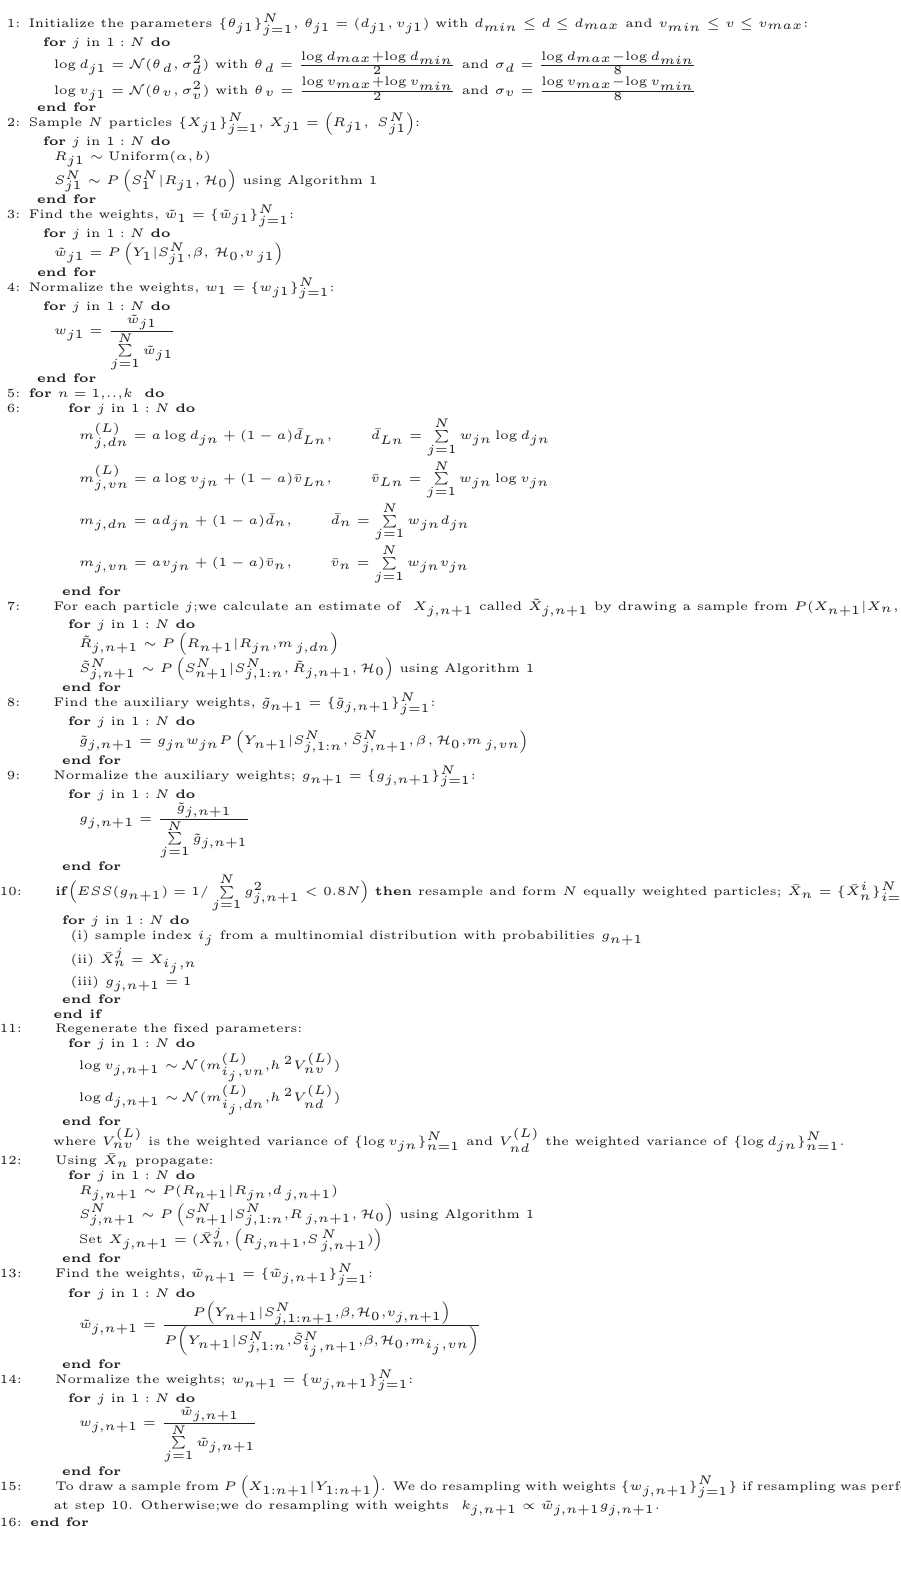
Algorithm 2 Kernel density particle